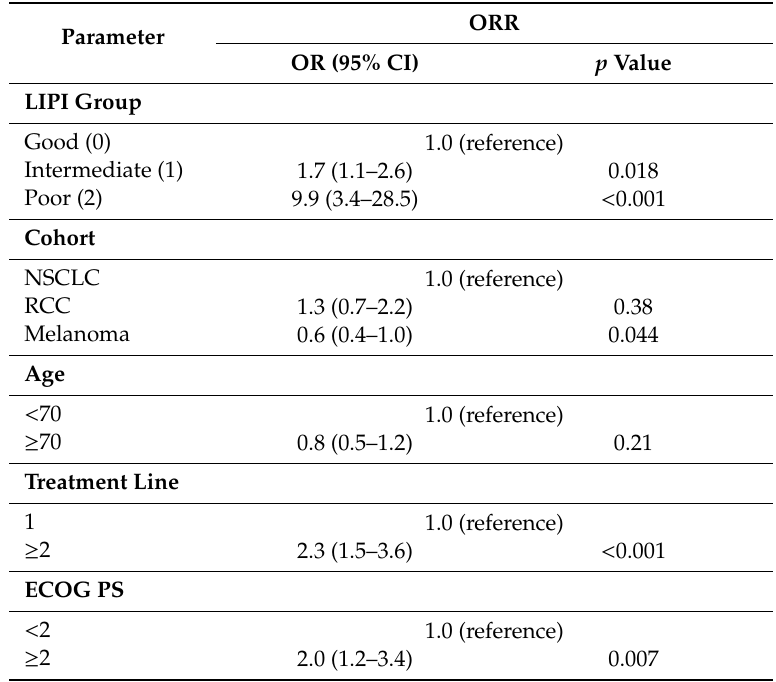
Table 4. Multivariate analysis of factors associated with objective response rate (ORR) in the pooled cohort.